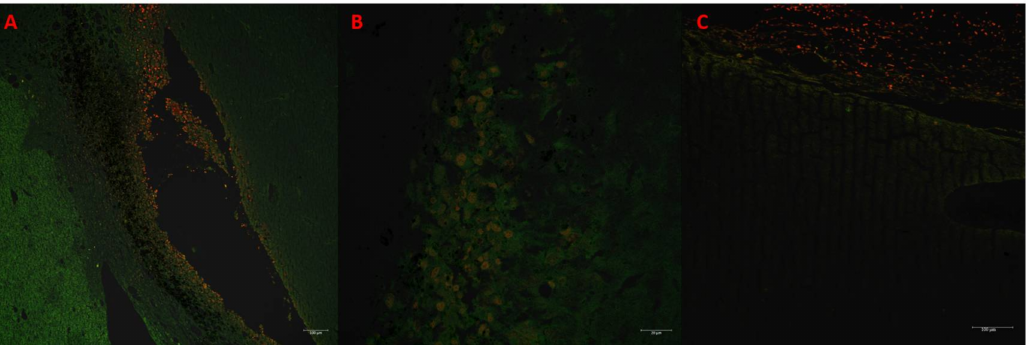
Figure 9. Confocal microscopy images presenting high Dox accumulation in the tumor core after treatment with Au-GSH-Dox ( A , B ). Bar graph 100 µ m and 20 µ m, respectively. Confocal microscopy image presenting Dox accumulation in the periphery of the tumor after treatment with Dox alone ( C ). Bar graph 100 µ